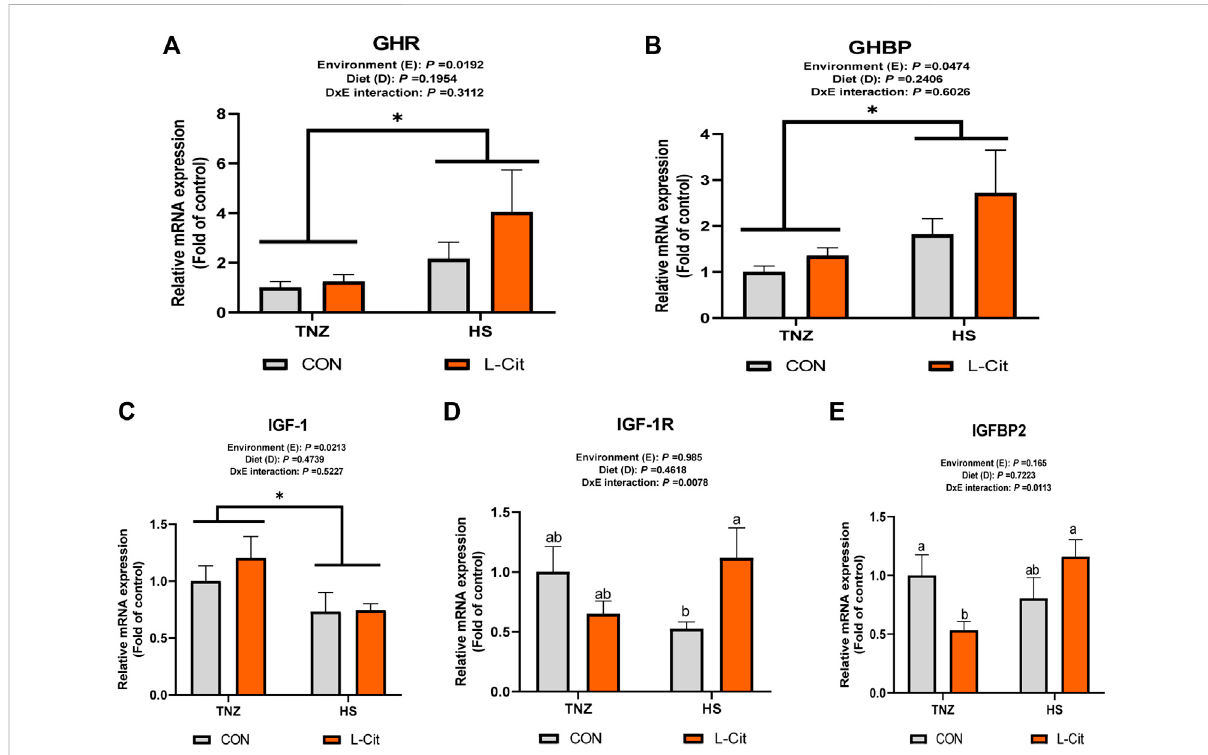
FIGURE 3 Effect of heat stress and l-citrulline supplementation on somatotropic axis gene in the breast muscle (A) Growth hormone receptor (GHR) (B) Growth hormone binding protein (GHBP) (C) Insulin-like growth factor-1 (IGF-1) (D) Insulin-like growth factor-1 receptor (IGF-1R) (E) Insulin-like growth factor-1 binding protein 2 (IGFBP2). Data were presented as mean ± SEM ( n = 8). Means with different alphabetical superscripts indicate signi fi cant differences in environment × diet interaction at p < 0.05 Asterisk indicates signi fi cant main effect of environment at * p <